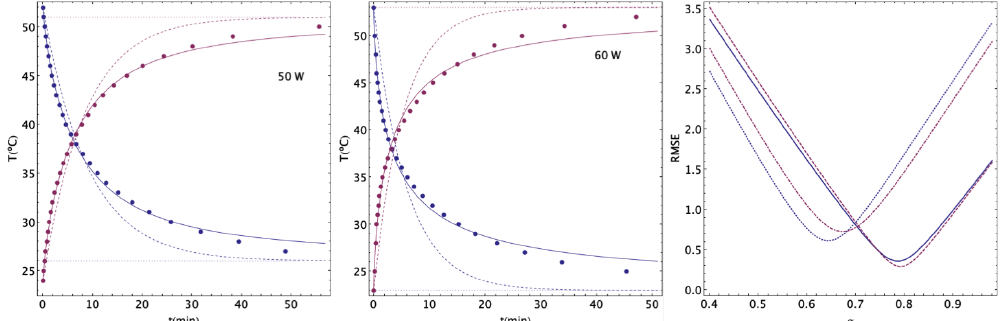
Figure 3. Evolution of the temperature of the chip within the luminaire for the heating (growing values) and cooling (decreasing values) with two different LED powers attached to two heat sinks of different sizes. The dots correspond to measurements, solid lines to the fractional version of Newton’s law of cooling, the dashed lines to the conventional version of Newton’s law of cooling, and the horizontal lines to the asymptotic temperatures. For the fits, T ( 0 ) and T f are fixed to the experimental values in each case and r and α are the free parameters. The plots on the right show how the root-mean-square error of the best fit for r depends on α for each setup. The solid line corresponds to cooling with 50 W, dashed to heating with 50 W, dotted to cooling with 60 W, dot-dashed to heating with 60 W. The best value of α in each case corresponds to the minimum of the